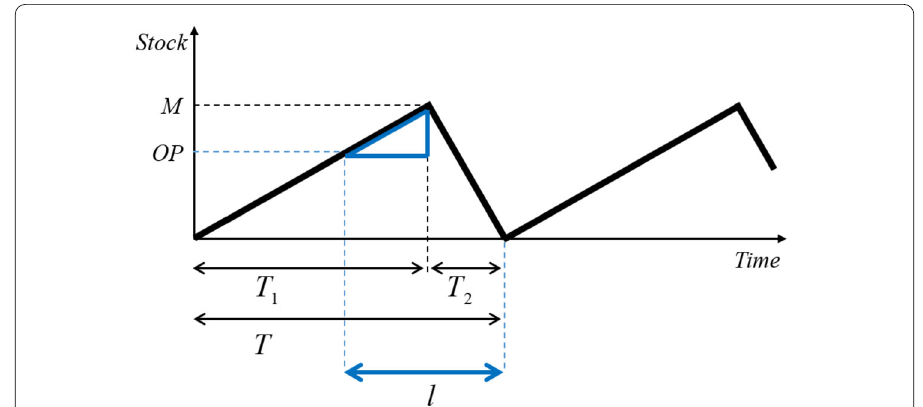
Figure 7 Stock quantity across time, lead time, and OP for Model